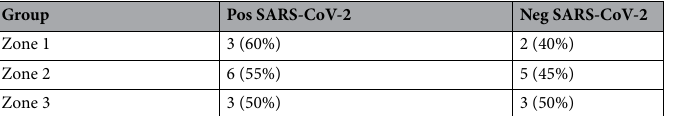
Table 3. Impact of physical distancing on SARS-CoV-2 transmission in the group of participants using medical face masks (community masks and/or surgical masks).